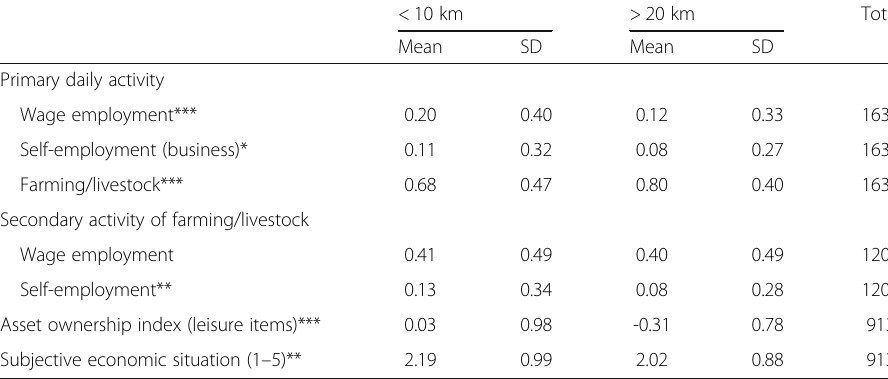
Table 3 Descriptive statistics of